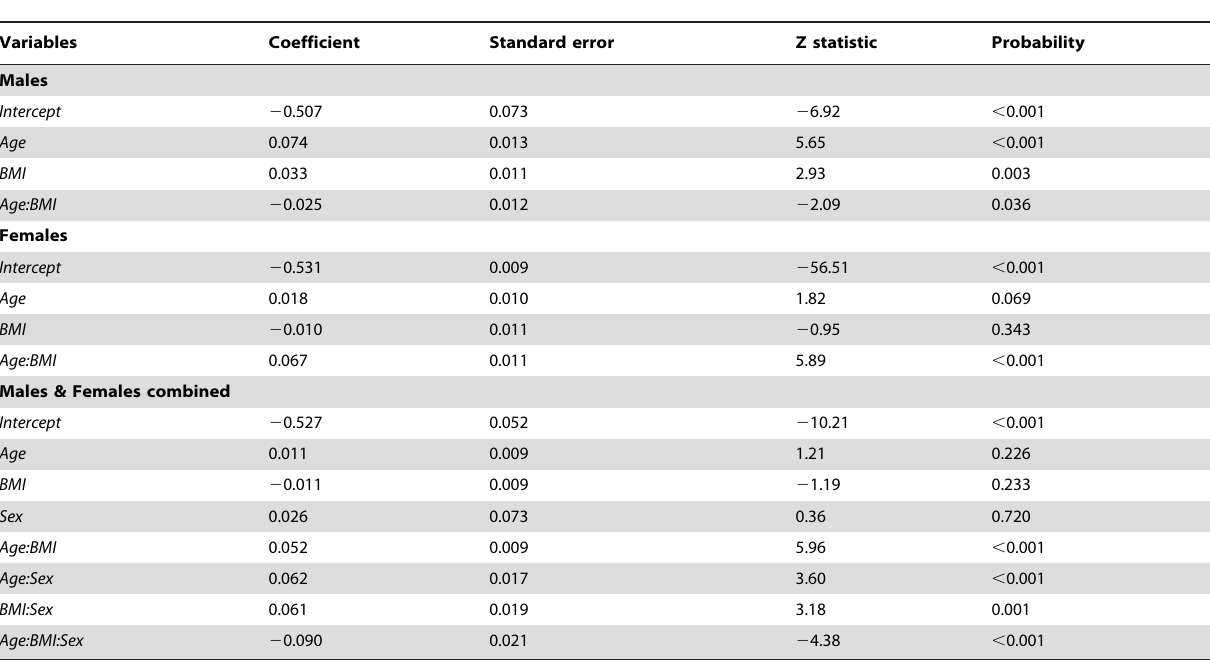
Table 3. Model coefficients for the influence of age, BMI on the proportion of neutrophils.